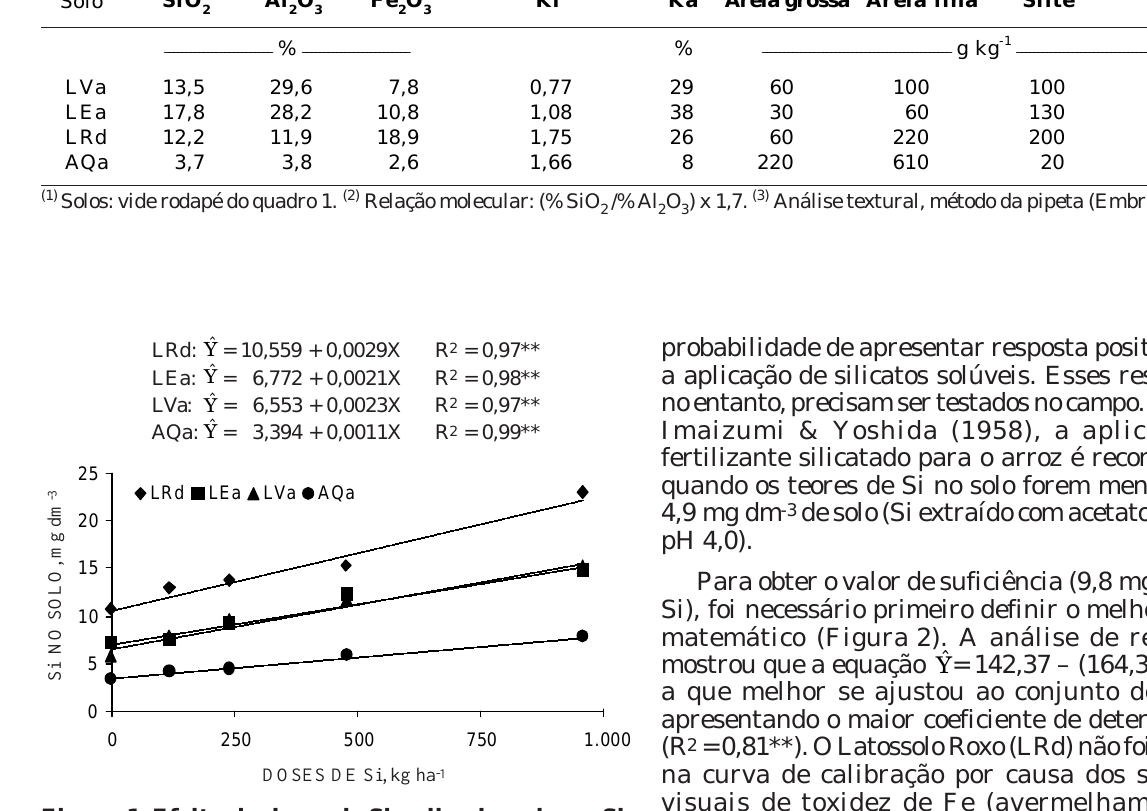
Figura 1. Efeito de doses de Si aplicado, sobre o Si “disponível”, em amostras de solo (0-20